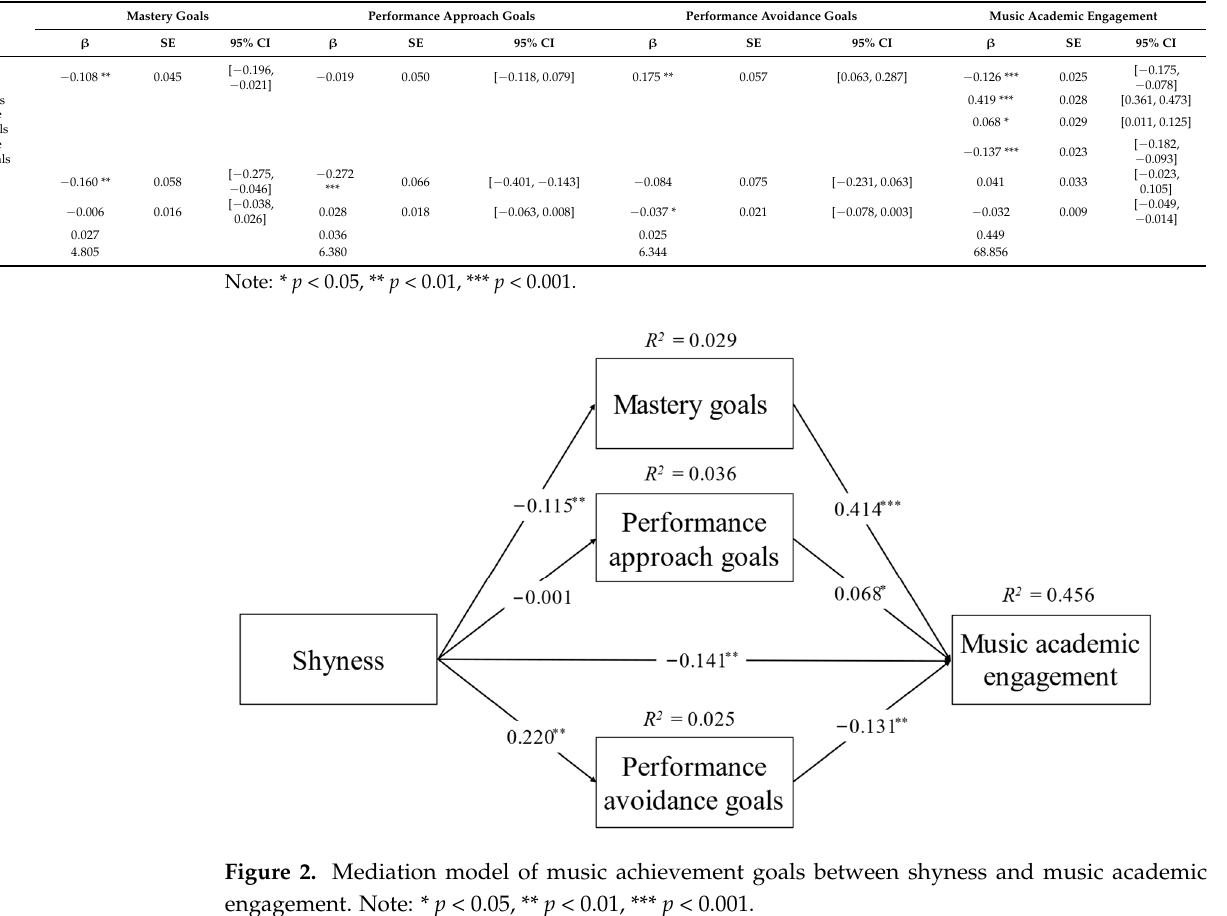
Table 2. Mediation model of music achievement goals between shyness and music academic engagement.